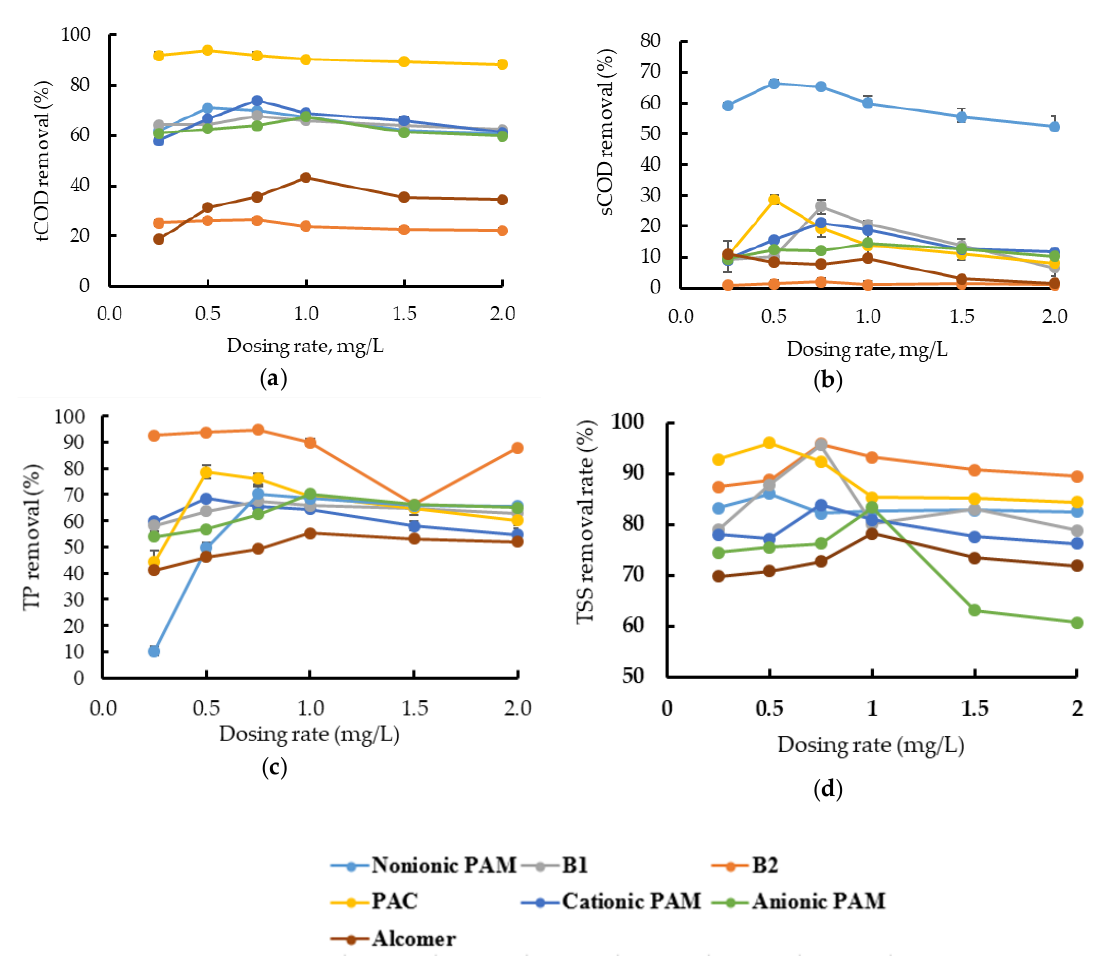
Figure 2. Percent removal by individual polymers with 15 mg/L ferric chloride (values are averages of triplicates): ( a ) tCOD, ( b ) sCOD, ( c ) TP, and ( d ) TSS.